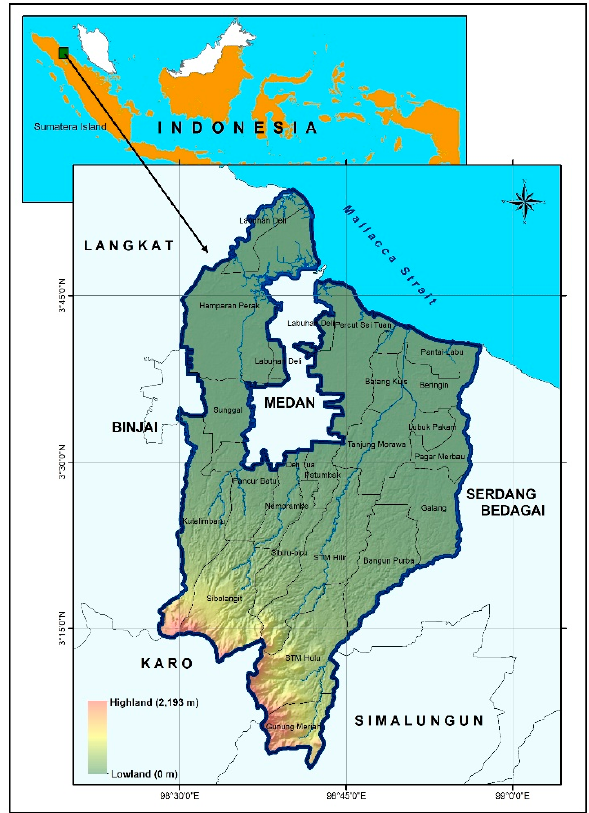
Figure 1. Location map of the study area.